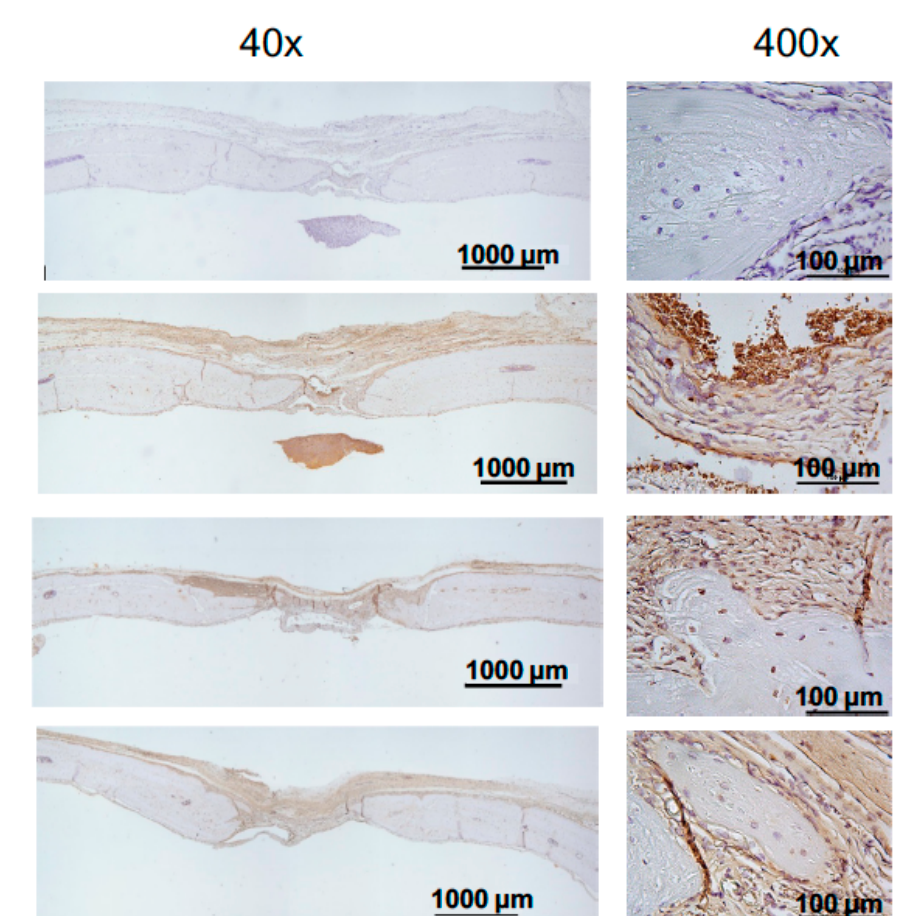
Figure 4. IHC staining of osteogenic factors BMP-2 of the cross section of the calvarial defects at Week 12 post-operation. Representative BMP-2-stained images of calvarial bone sections from each group: Non-antibody staining control ( a ), Control ( b ), DM ( c ), and DM + PBMT treatment ( d ). Calvarial bone defects (3 mm) were generated in adult Wistar rats. PBMT treatment (4 J/cm 2 ) was applied daily. The calvarial bone sections were collected at Week 12 postoperatively and stained with BMP-2 antibodies. Scale bar, 1000 μ m for 40× and 100 μ m for 400×.